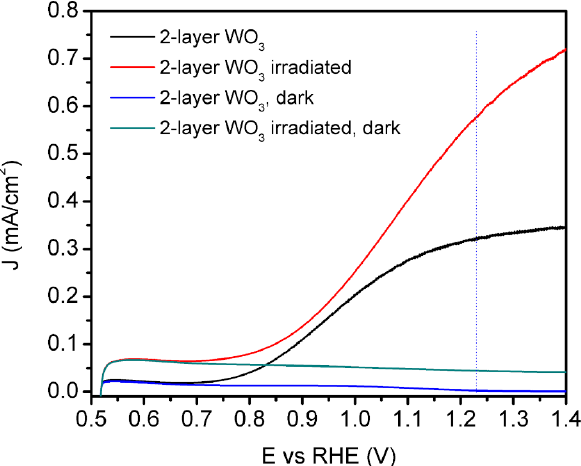
Figure 6. Linear sweep voltammetry curves of double-layer WO 3 before and after the modification with IPIB of 6 A/cm 2 ion beam current density.